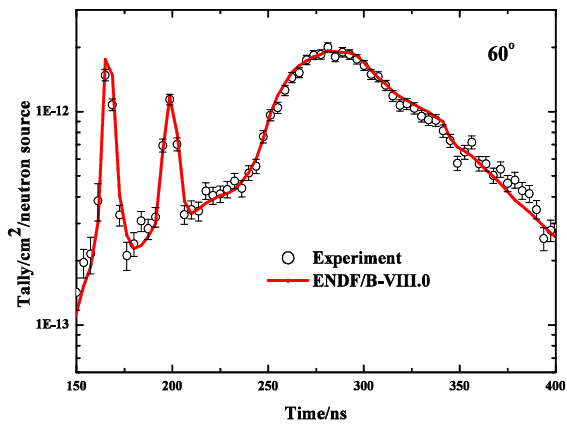
Fig.3 Leakage neutron spectrum from polyethylene sample